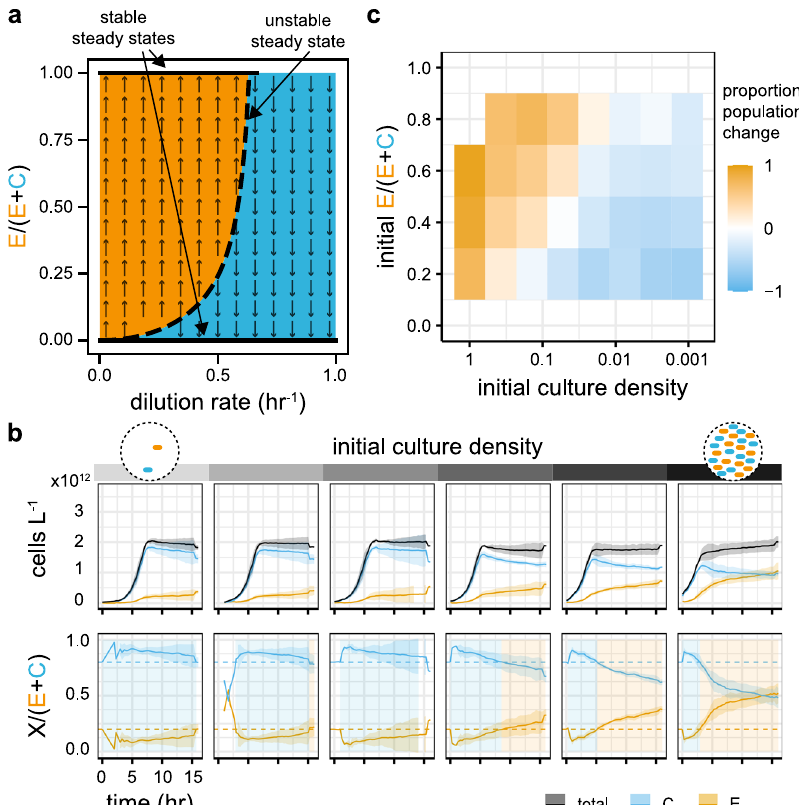
Fig. 3 Environment dilution can control relative strain fi tness. a Analysis of the mathematical model with varying dilution rate. Solid black lines show the stable steady states (extinction of one or other strain), the dashed black line indicates an unstable steady state. The arrows show the direction of population change on either side of the unstable manifold. b Dilution rate is approximated by varying the initial density of the co-cultures in the microtitre plate; lower initial density approximating faster dilution rates. We observe the same switch, from competitive exclusion to bacteriocin killing, predicted by the model. c The “ winning ” strain after 5 h of growth in co-culture, over a range of initial population ratios, mimics the model prediction. In b the lines show the mean of the rolling mean (centred window size = 3) and the shaded ribbons show the standard deviation of three replicates. In c , each shaded rectangle shows the mean proportional population change of three replicates, calculated at 5 h